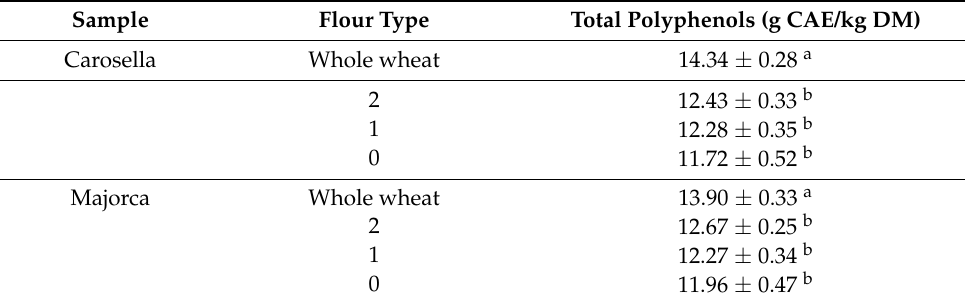
Table 2. Total polyphenol content of Carosella and Majorca samples.